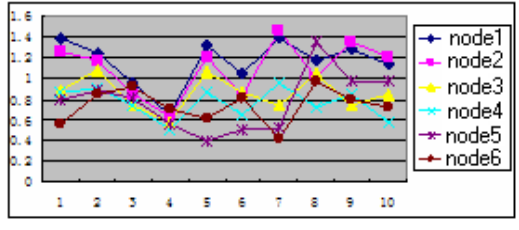
Fig.4. The optimal projection result